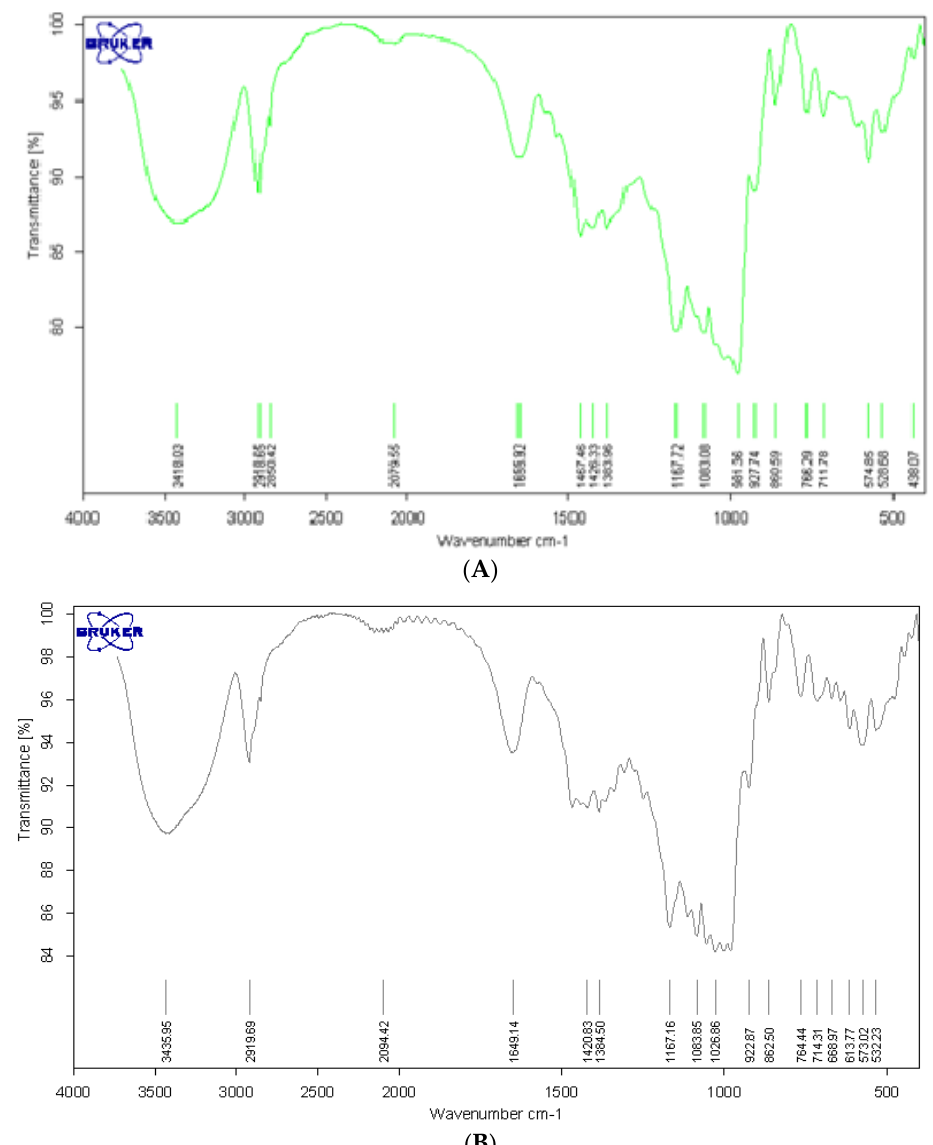
Figure 1. FTIR spectra of ( A ) sago starch; ( B ) pregelatinised sago starch.